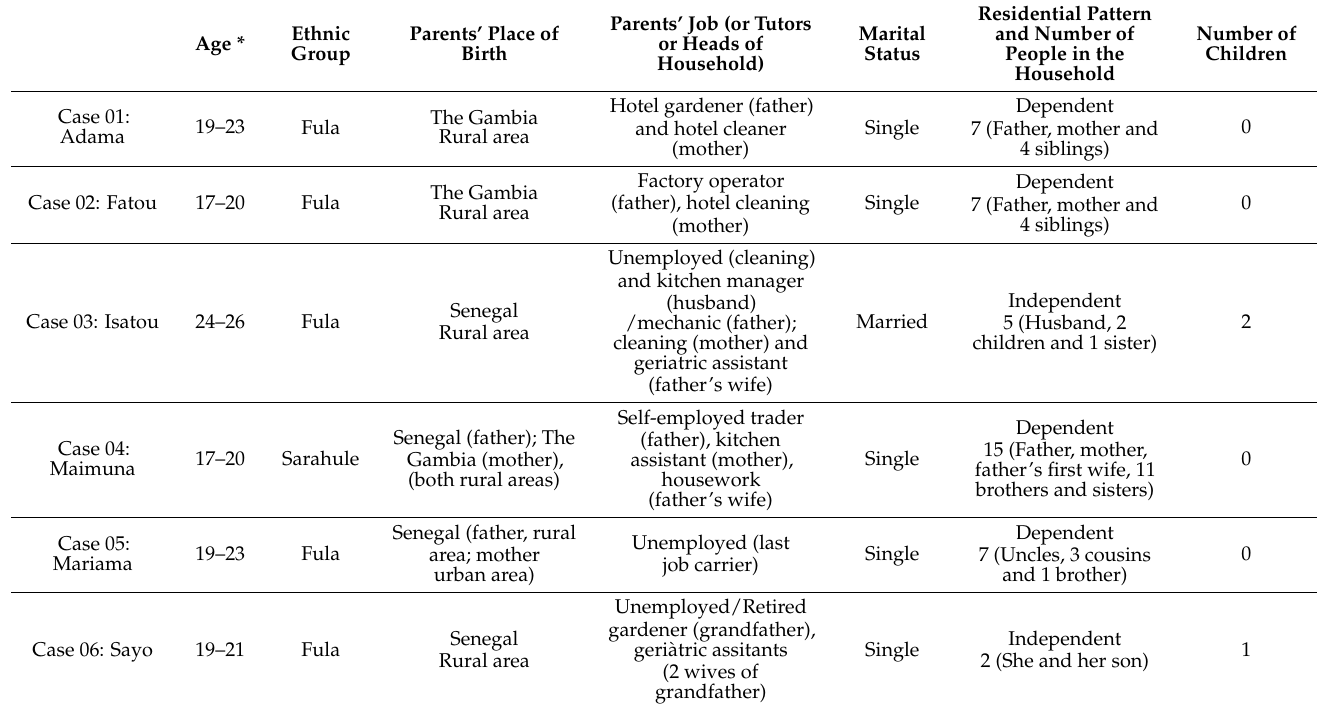
Table 1. Main socio-demographic